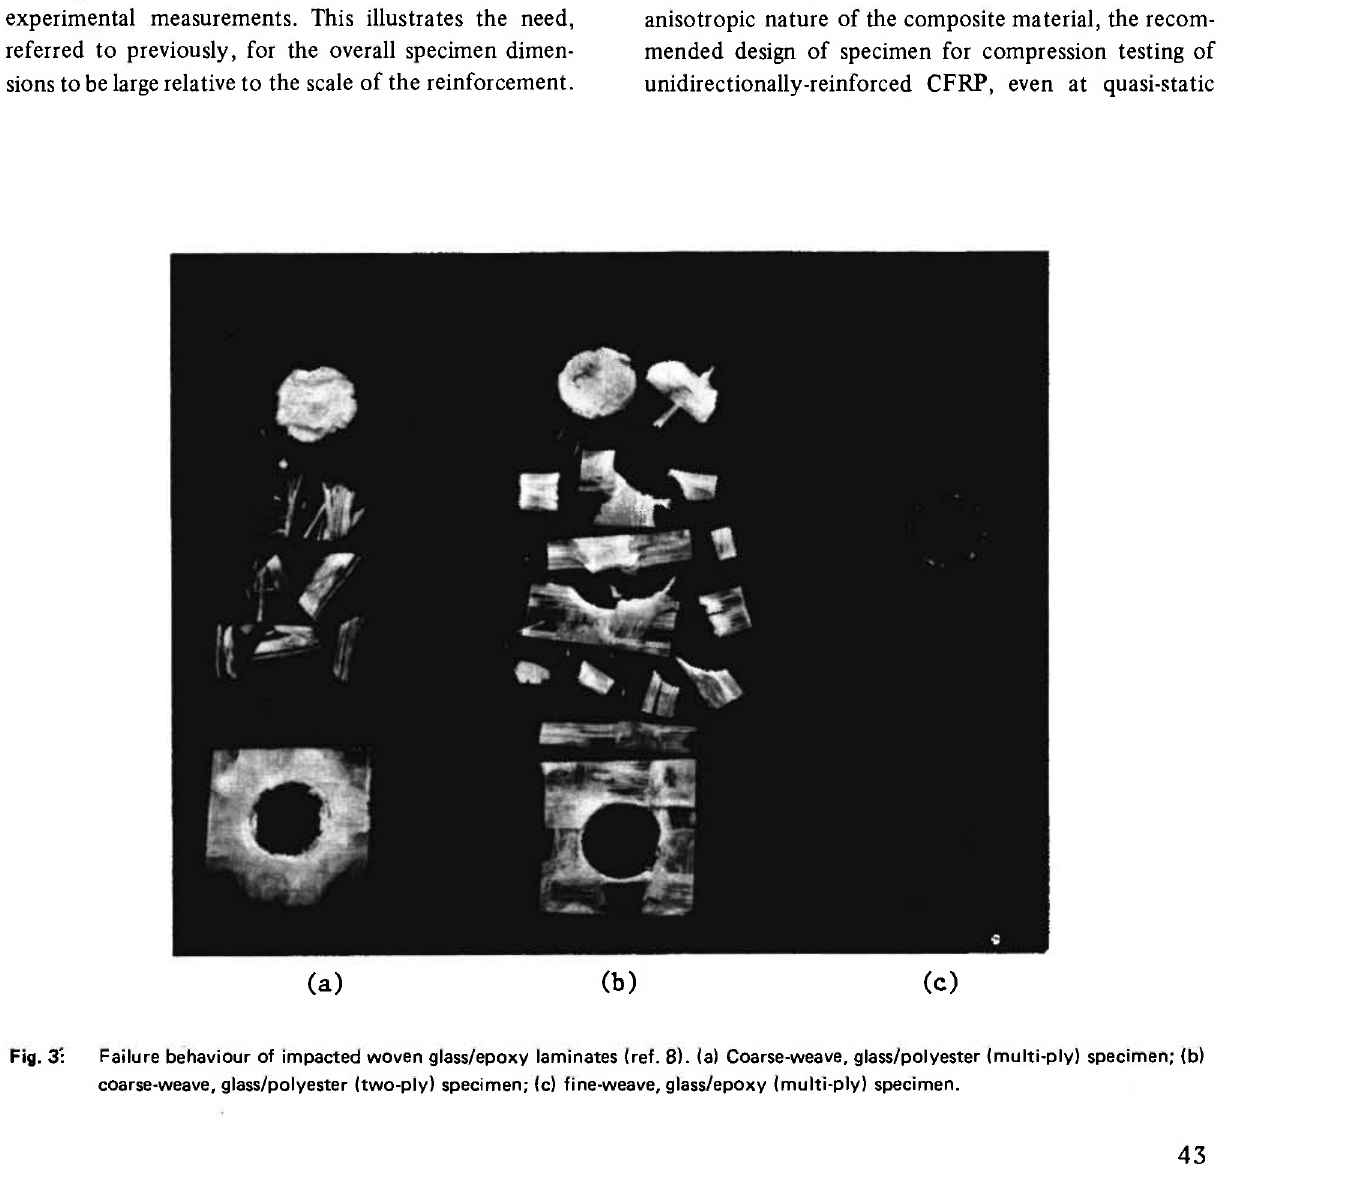
Fig. 3': Failure behaviour of impacted woven glass/epoxy laminates (ref. 8). (a) Coarse-weave, glass/polyester (multi-ply) specimen; (b) coarse-weave, glass/polyester (two-ply) specimen; (c) fine-weave, glass/epoxy (multi-ply)